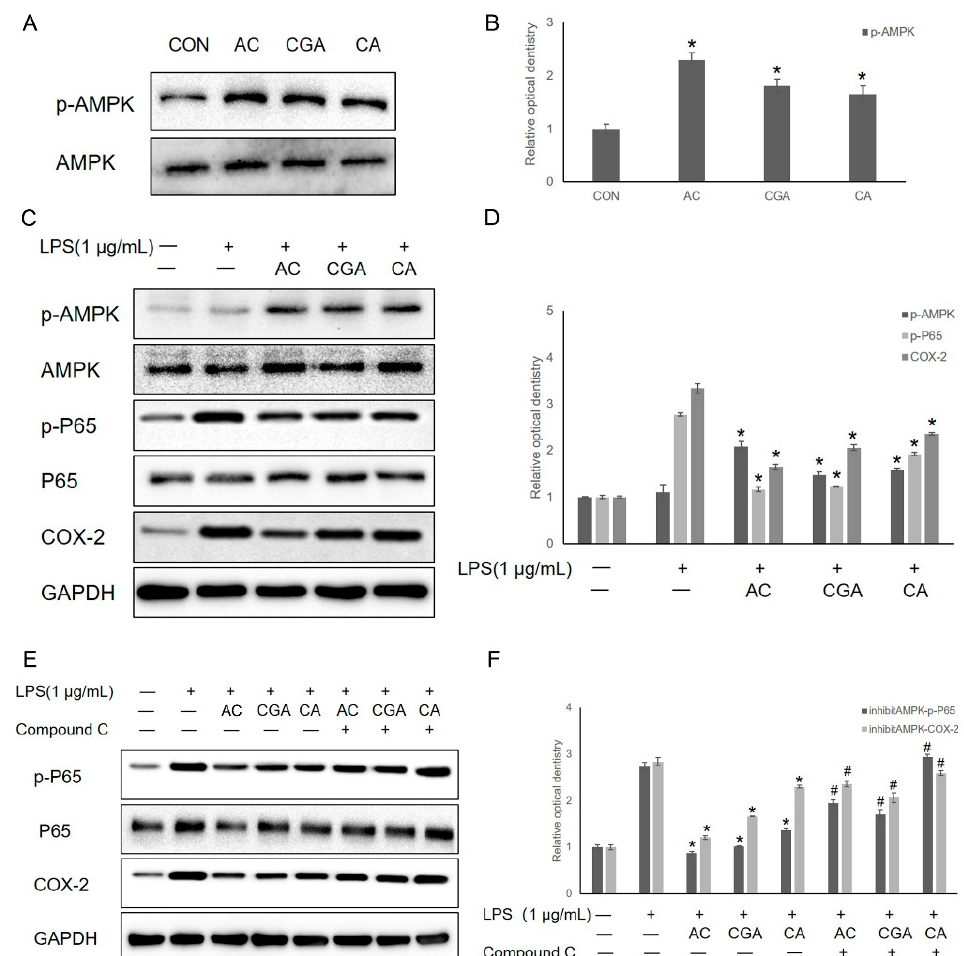
Figure 4. Western blot analysis. ( A ) The protein expression level of p-AMPK/AMPK in AC, GA, and CA pretreatment. ( B ) Relative optical density was measured using Image J software. ( C ) The expression levels of p-AMPK, AMPK, p-NF- κ Bp65, NF- κ Bp65, and COX-2 were determined by Western blot. ( D ) Relative optical density was measured using Image J software. ( E ) The expression levels of p-NF- κ Bp65, NF- κ Bp65, and COX-2 were determined using Western blot. ( F ) Relative optical density was measured using Image J software. * p -value < 0.05. vs. LPS only treated control. # p -value < 0.05. vs. compound C untreated control. “-” represent untreated group; “+” represent treated with LPS or compound C group.